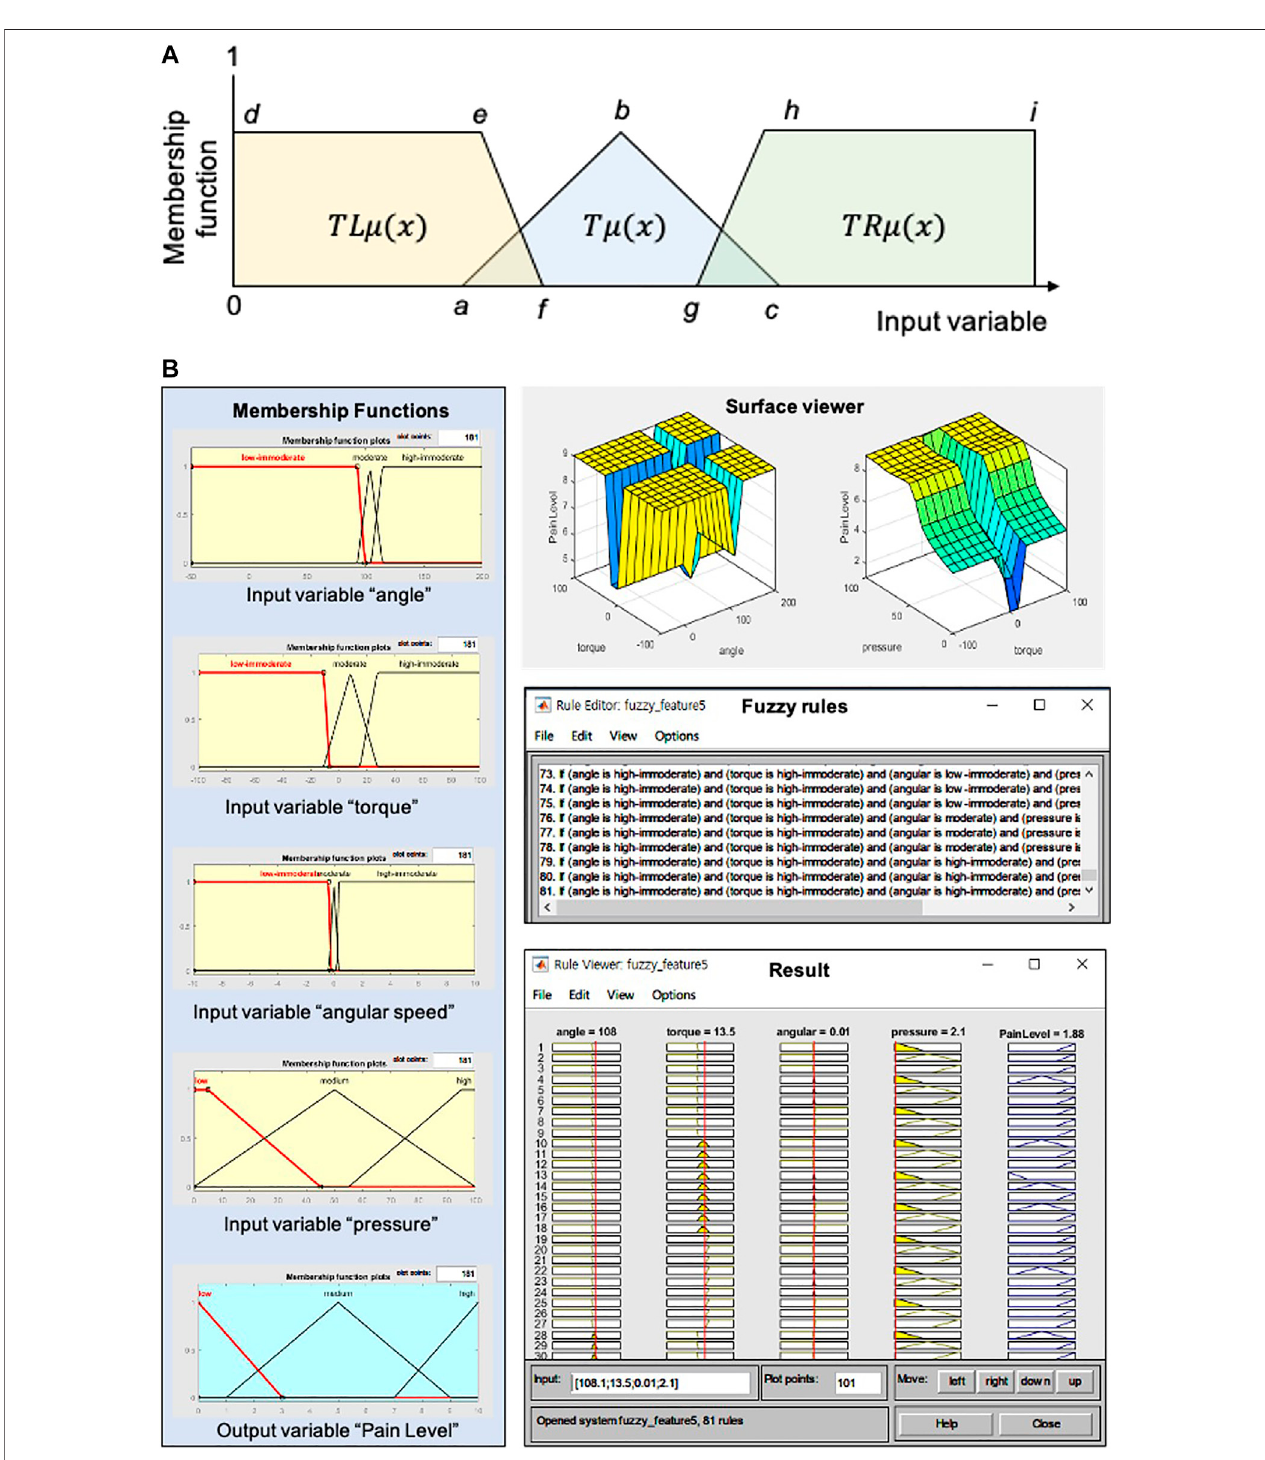
FIGURE3| Fuzzylogicmethodforthepainlevel: (A) fuzzymembershipfunctionsforfourinputvariables(angle,torque,angularvelocity,andSMAP)andanoutput variable(painlevel),surfaceviewofinputvariables,81fuzzyrules,andresult.SMAPmeansthesignalmagnitudeareaofpressurevalues; (B) fuzzymembershipfunctions for four input variables (angle, torque, angular velocity, and SMAP) and an output variable (pain level), surface view of input variables, 81 fuzzy rules, and result. SMAP means the signal magnitude area of pressure values.